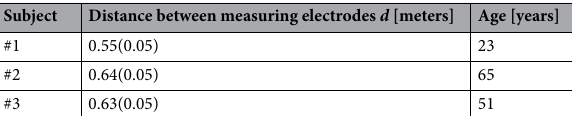
Table 1. Study group characteristics.